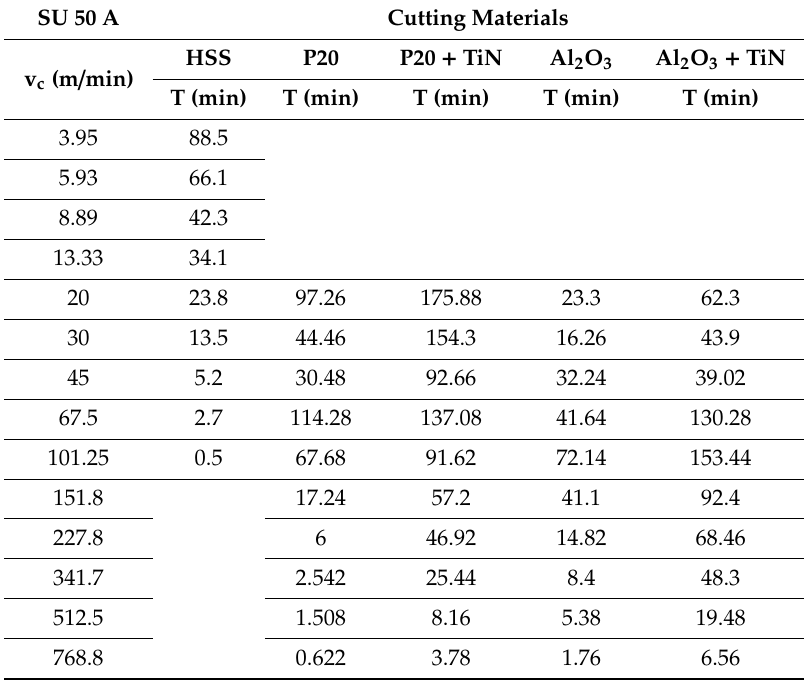
Table 7. T-v c dependences created by the least-squares method (conventional lathe).